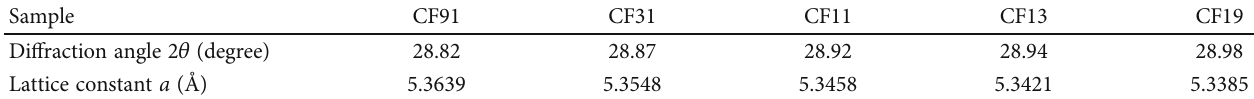
-Fe O mixed oxides with di ff erent CF molar ratios calcined at 650 ° C for 2h. 2 2 3